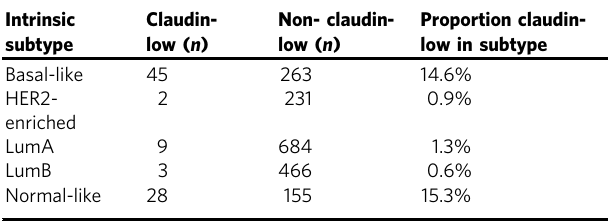
Table 1 Distribution of claudin-low tumors by intrinsic subtype in the METABRIC